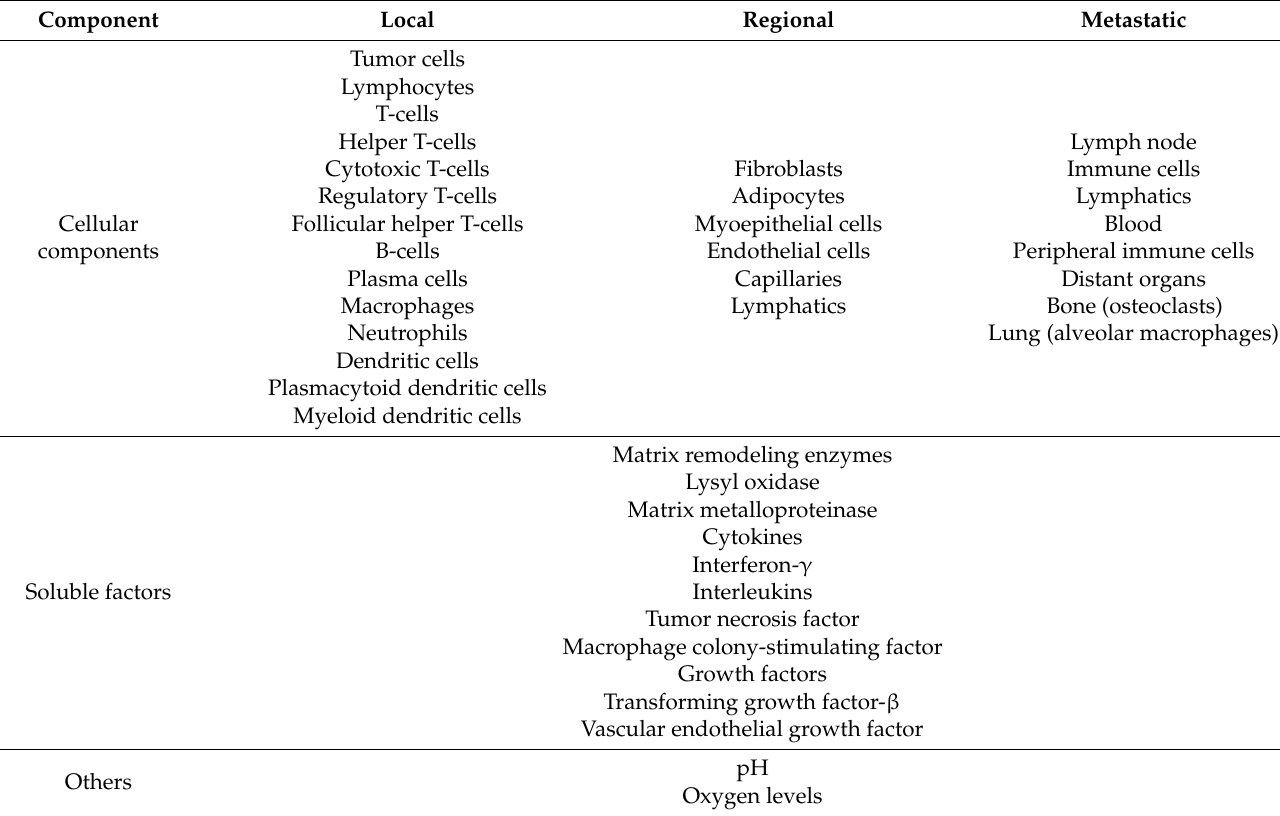
Table 1. Components of the tumor microenvironment with delineated